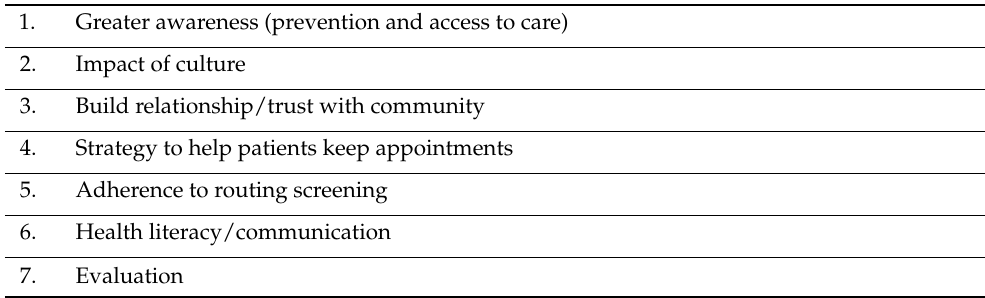
Table 1. Breast cancer community partnership